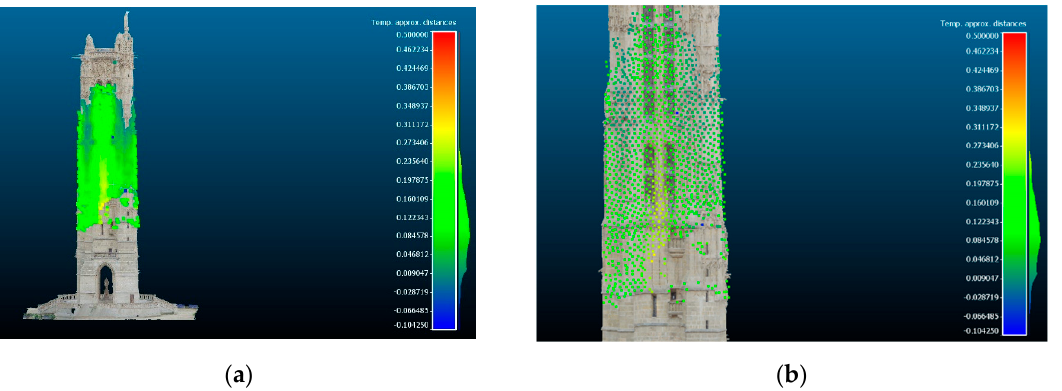
Figure 28. Distances comparison between the obtained point cloud and existing 3D model in ( a ) and a